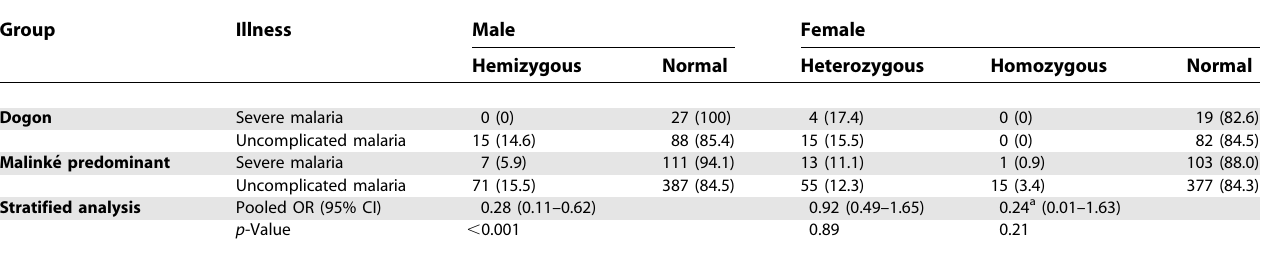
Table 2. Distribution of Severe and Uncomplicated Malaria in HbAA Children (cid:4) 5 y According to Ethnicity, Sex, and G6PD Genotype Group Illness Male